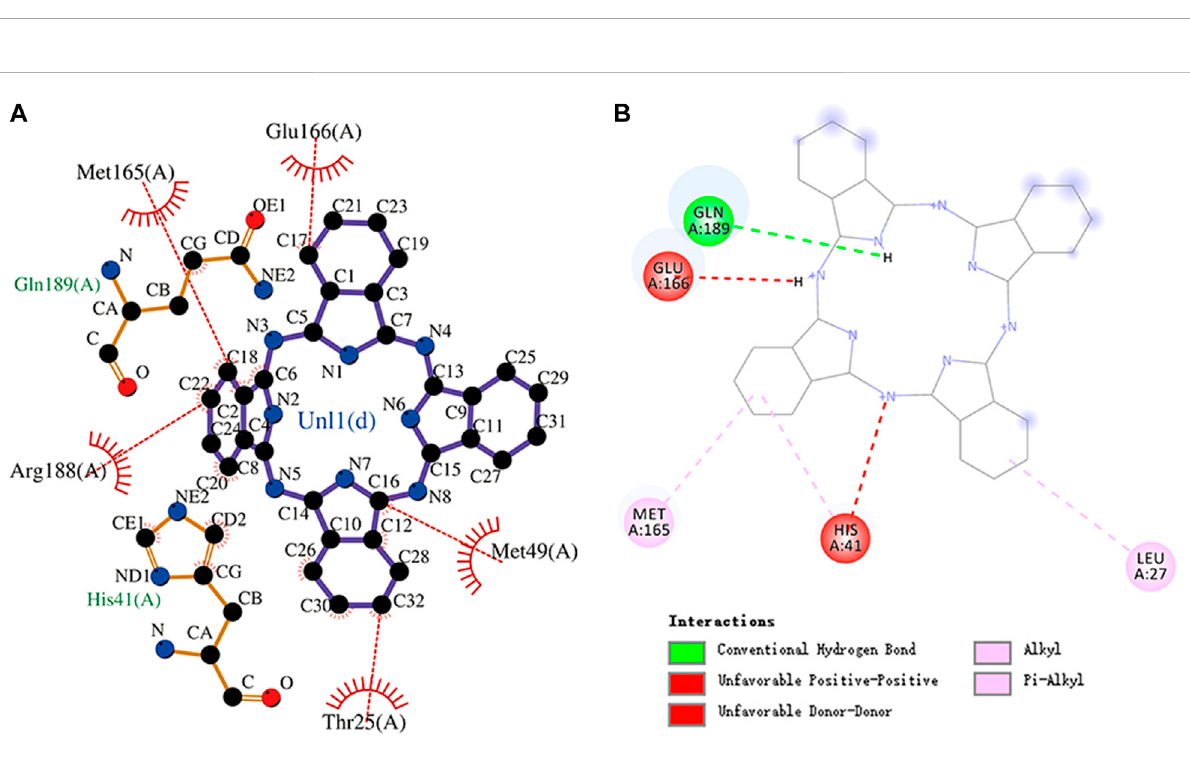
FIGURE 10 (A) Hydrophobic interactionbetweenM pro andphthalocyanine and (B) two-dimensionalplotof phthalocyanine interaction with theaminoacid